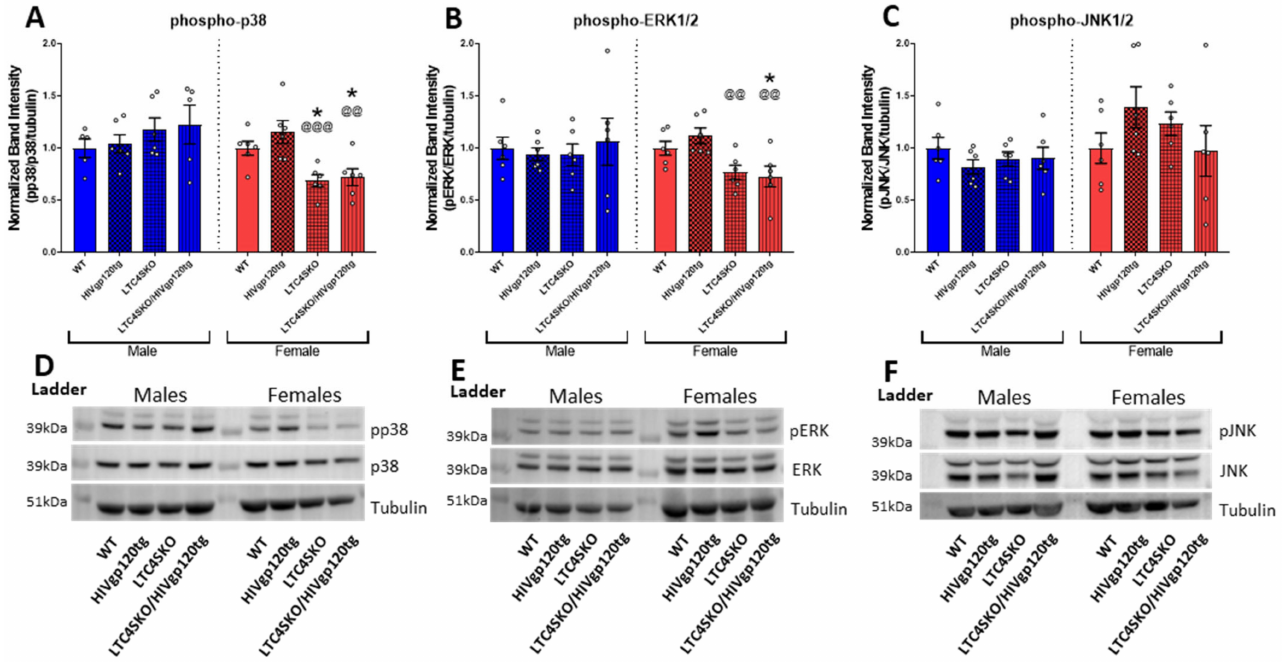
Figure 3. MAPK signaling pathway in female LTC4SKO mice shows the reduced activity levels of p38 and ERK in protein brain lysates. The quantification of Western blot densitometries of: phos- phorylated p38 MAPK (pp38)/total p38/tubulin (p38) ( A ); phosphorylated ERK1/2 (pERK)/total ERK1/2/tubulin (ERK) ( B ); and phosphorylated JNK1/2 (pJNK)/total JNK1/2/tubulin (JNK) ( C ) all normalized to their respective wild type control. Representative images of the blots are shown with male and female samples separated by a protein ladder lane are for p38 ( D ), ERK1/2 ( E ), and JNK1/2 ( F ). Male (blue) and female (red) data sets are shown, separated by a dashed line. Values in graphs are mean ± s.e.m.; n = 4–6 per genotype for both male and female data sets, 12 months of age. Individual data points are represented in the graphs by an symbol. ANOVA and Fisher’s (cid:35) PLSD post hoc test for males and females were analyzed independently while normalized to their respective WT controls; p -value level of significance is as follows: * p ≤ 0.05, @@ p ≤ 0.01, @@@ p ≤ 0.001—while the p -value significance correlations are symbolized as follows: * indicates significances from the WT, @ indicates significances from